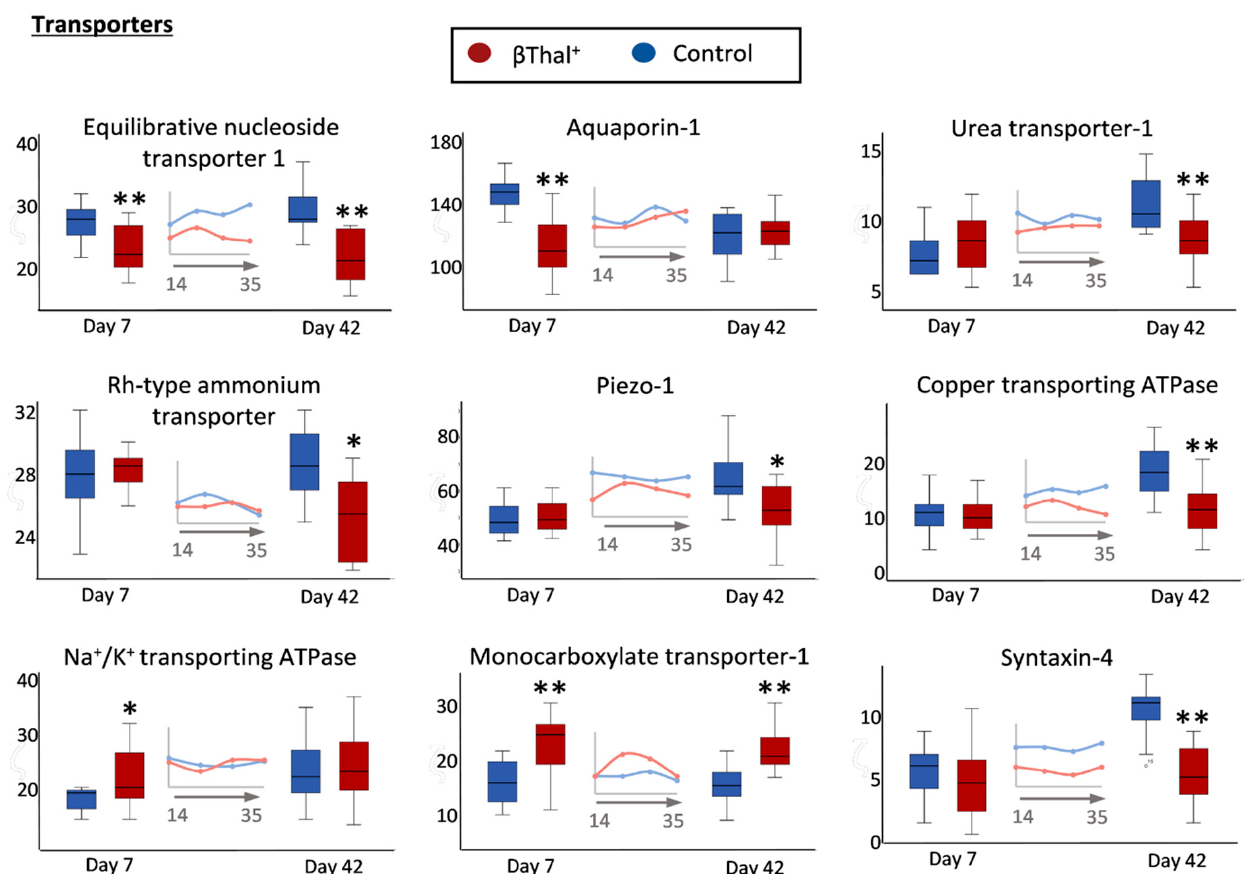
Figure 4. Proteomics analysis of stored RBC membrane: transporters, channels, and pumps. Levels of integral proteins involved in transport across the membrane in β Thal + and control RBCs throughout storage. Inserts: pooled analysis of membrane samples at weekly intervals. (*) p < 0.05 β Thal + vs. controls; (**) p < 0.05 and fold > 1.25 β Thal + vs. controls.